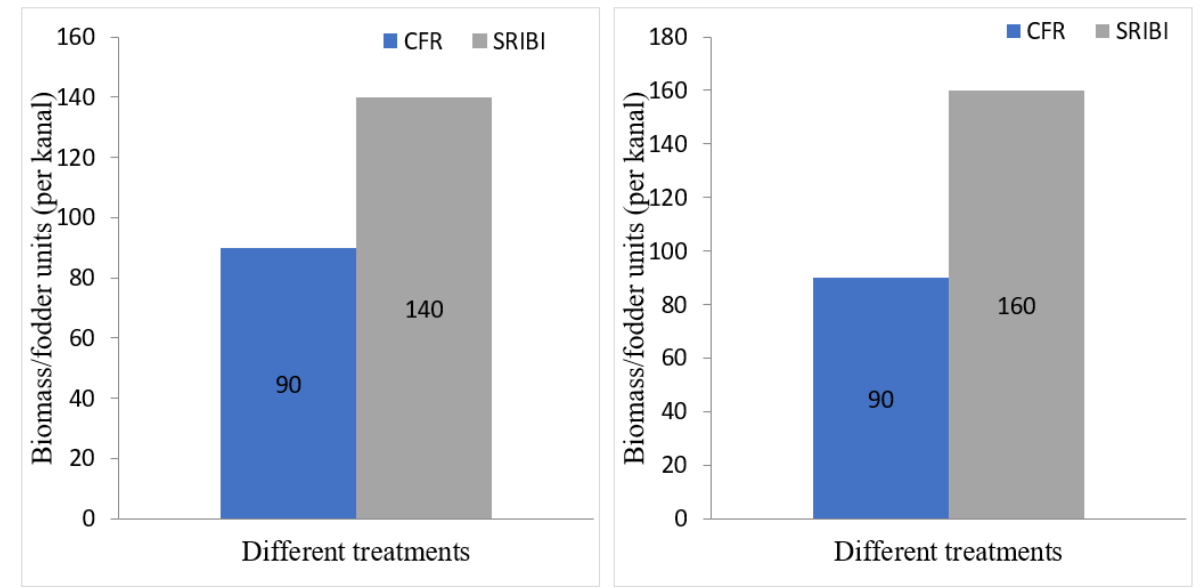
Figure 8. Number of fodder units observed in the different treatments ( Left : 2019; Right : 2020).